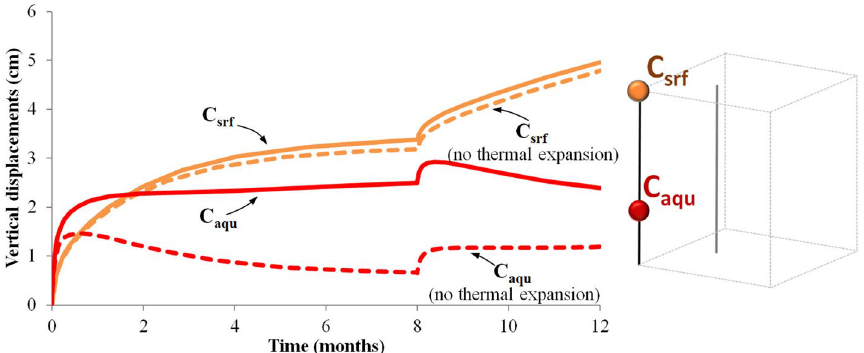
Fig. 14 Vertical displacements with thermal expansion and without thermal expansion on the top of the central well (C srf ) and on the top of the aquifer on the central well (C aqu )